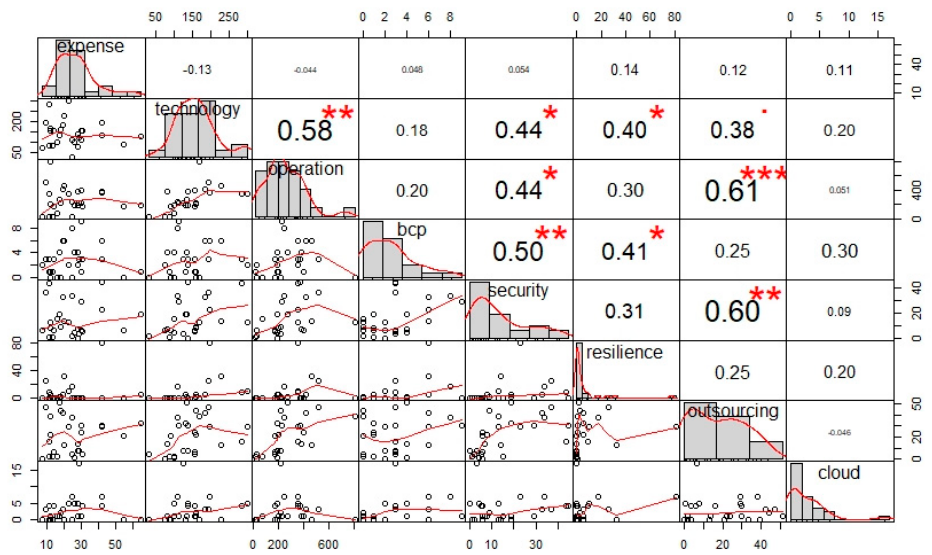
Figure 4. Chart showing the correlation between the frequency of the variables related to resilience as measured from the annual reports. Each significance level is associated to a symbol: p -values (0, 0.001, 0.01, 0.05, 0.1, 1) <=> symbols (***, **, *, .)